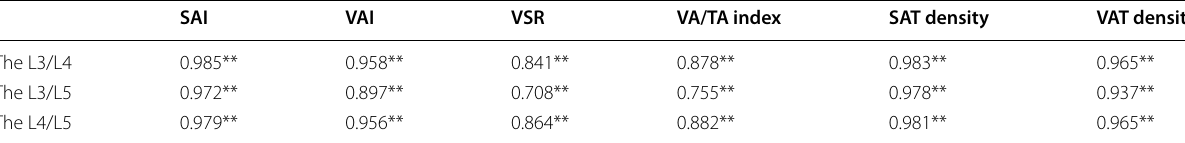
SAI, subcutaneous adipose index; VAI, visceral adipose index; VSR, VAT/SAT ratio; VA/TA: VAT/Total adipose tissue; SAT, subcutaneous adipose tissue; VAT, visceral adipose tissue; L3, third lumbar vertebra; L4, fourth lumbar vertebra; L5, fifth lumbar vertebra ** p <